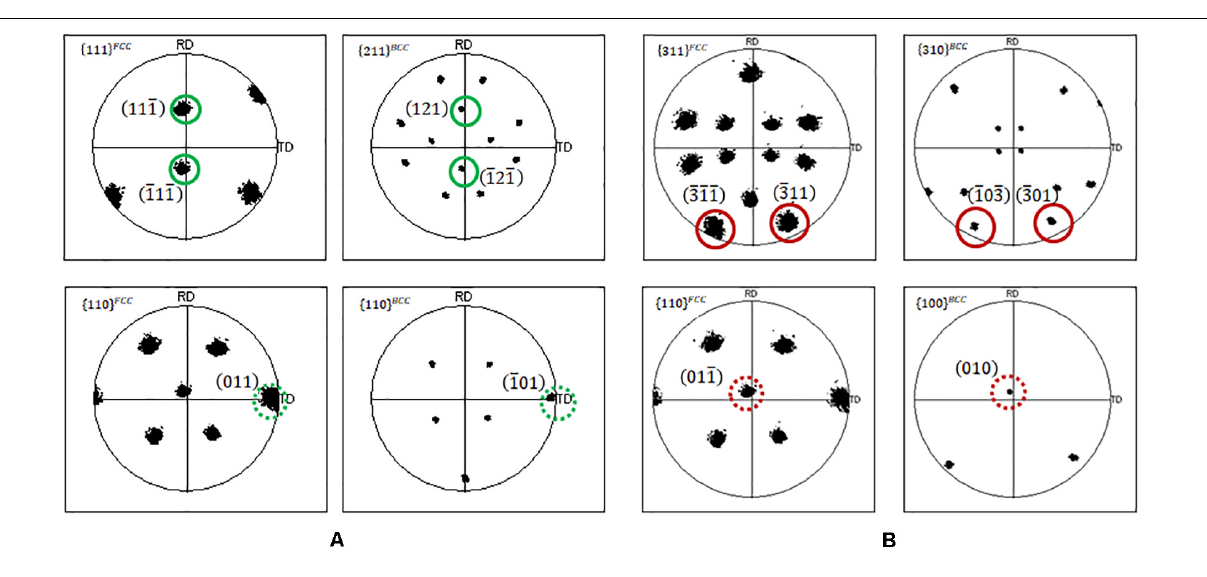
FIGURE 5 | Selected pole figures for grain 2, see Figure 3B , illustrating the primary (A) and the secondary (B) crystallographic orientation relationship between FCC and the parent BCC phase. Full circles mark the superposing poles, which correspond to the common planes. Dotted circles mark the superposing poles, which correspond to the common direction. Common planes and directions are indexed with the corresponding